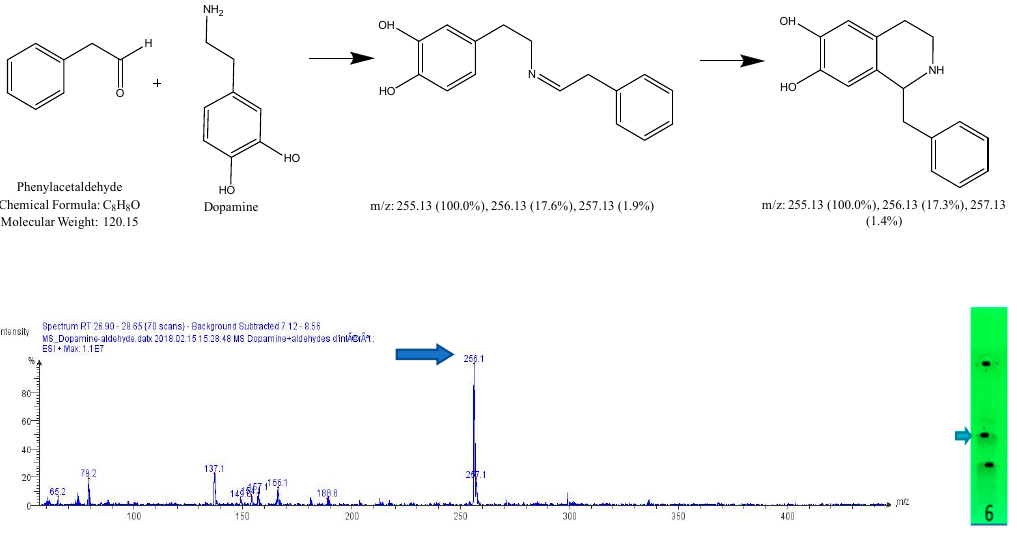
Figure 9. Expected reaction between dopamine and phenylacetaldehyde. Mass spectrum obtained for the 2nd spot of the reaction mixture on MS grade TLC plate.